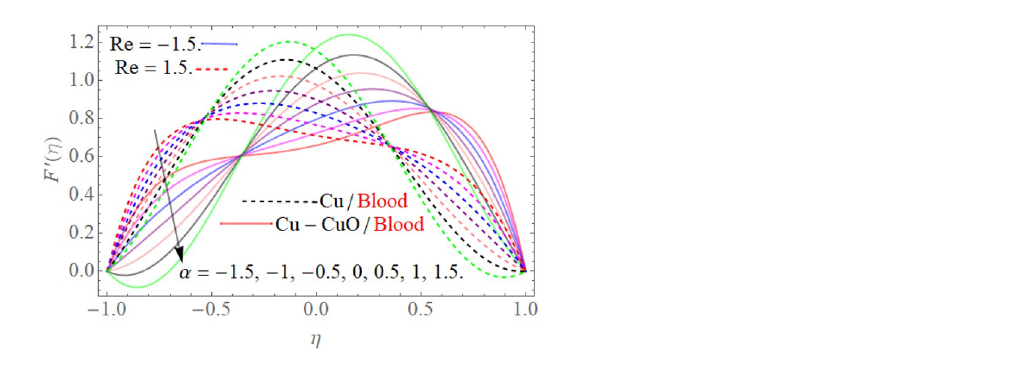
Figure 3. α influence on the F ′ (η)